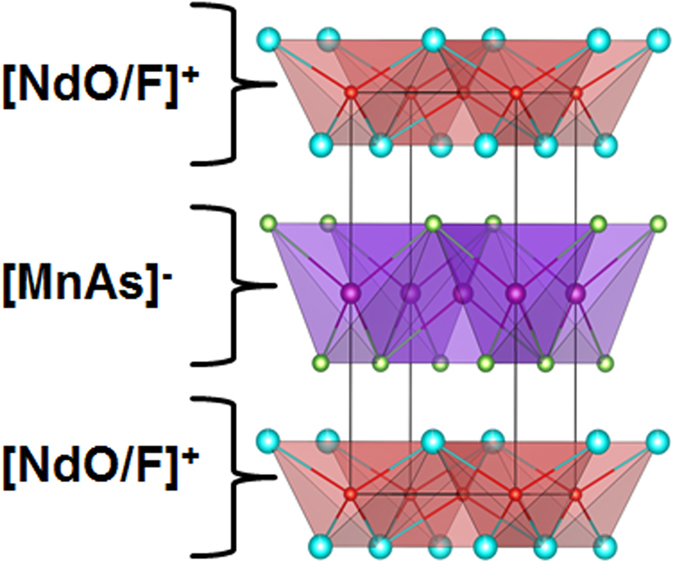
Crystal Structure of NdMnAsO0.95F0.05.The (NdO/F)+ and (MnAs)− slabs are labelled.